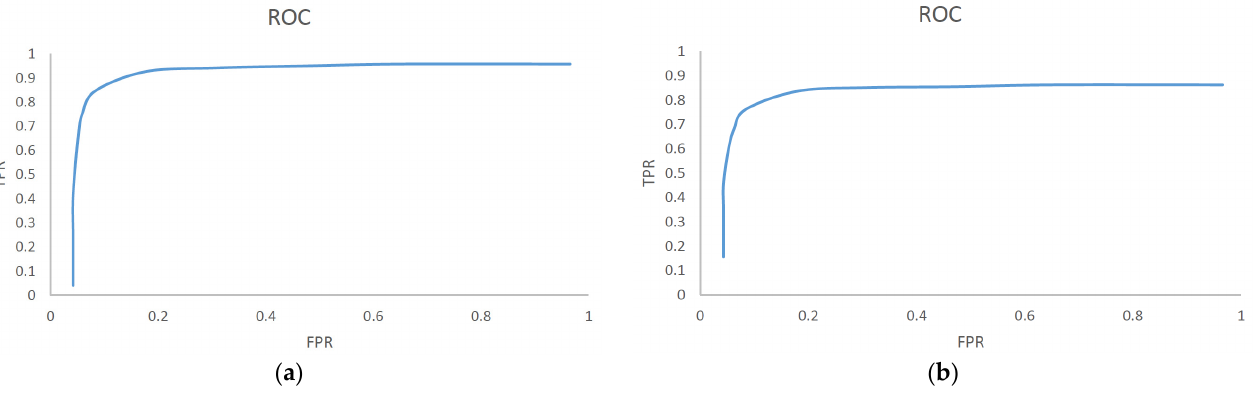
with different epoch range counts (Figure 5a,b).